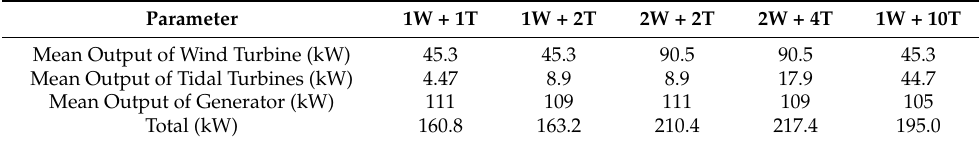
Table 12. Share of wind and tidal turbines in producing electricity and meeting demand.